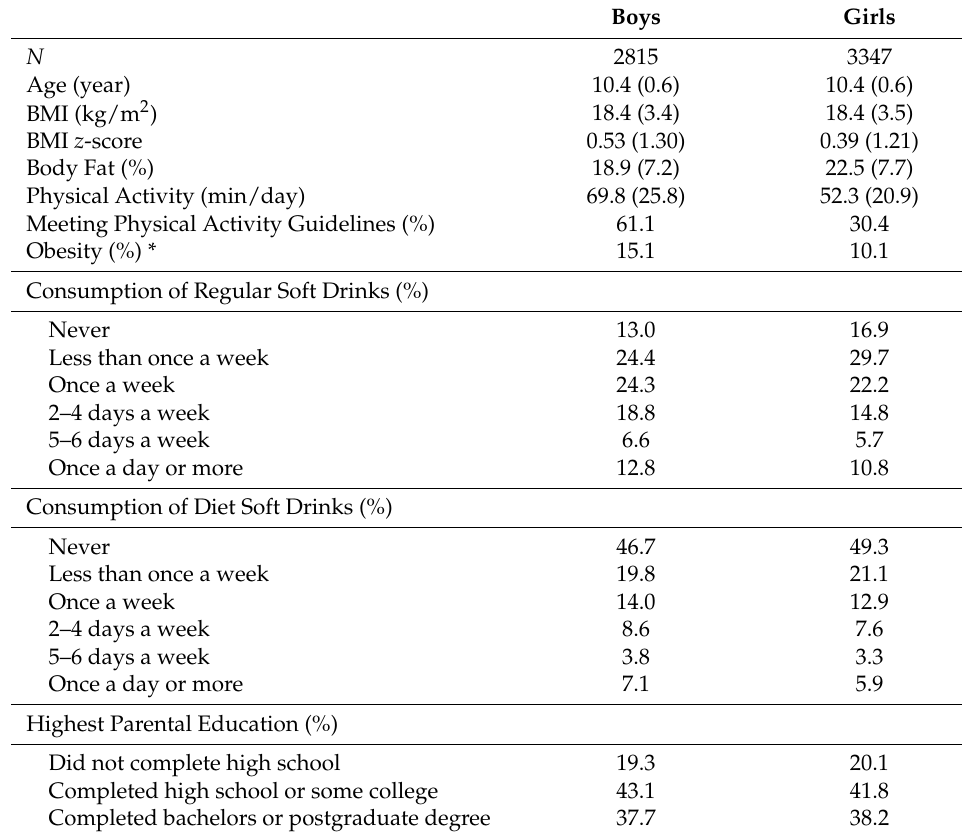
Table 1. Descriptive statistics of participants involved in the International Study of Childhood Obesity, Lifestyle and the Environment (ISCOLE).